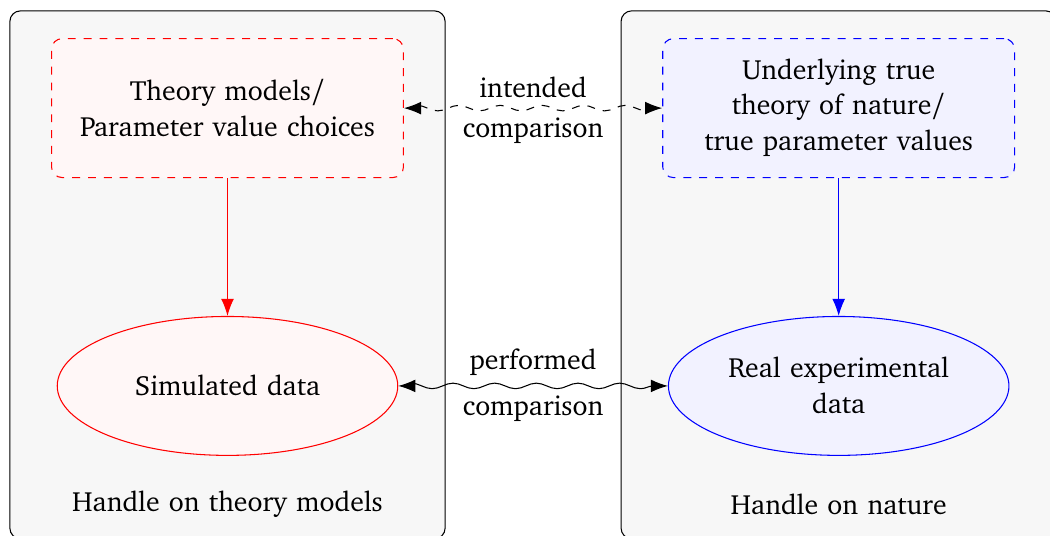
Figure 1: A diagram illustrating the simulation-based inference paradigm used in high-energy physics for testing theory models against experimental